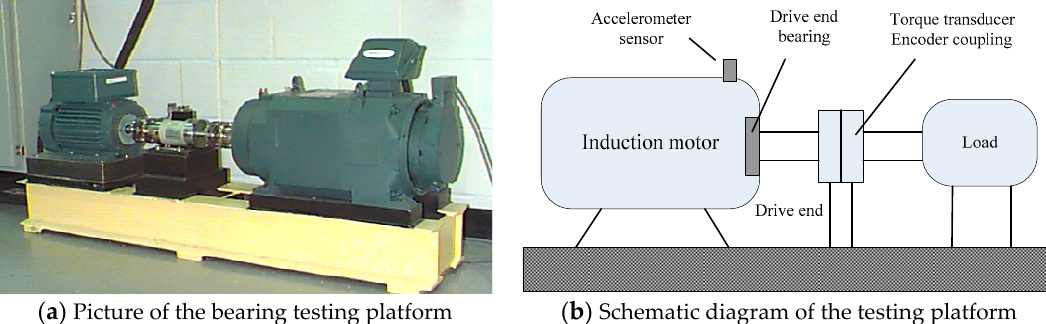
Figure 16. Rolling bearing failure test rig of Case Western Reserve University (CWRU) [40].